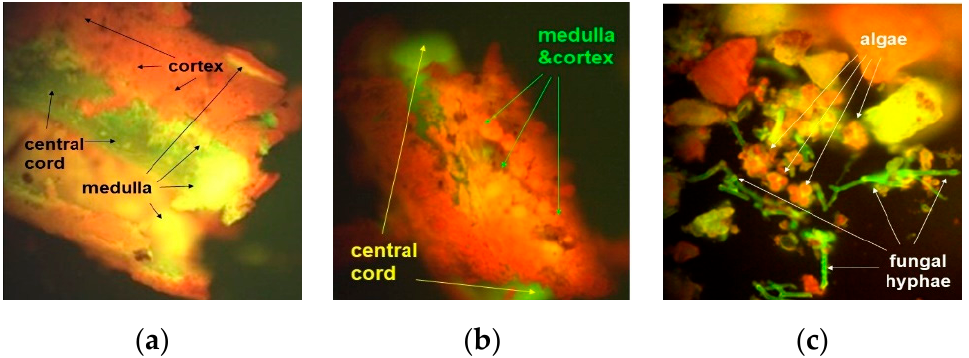
Figure 2. Microstructure of unground U. barbata lichen thallus—FM images with different magnifications: 100× ( a ) and 400× ( b , c ).